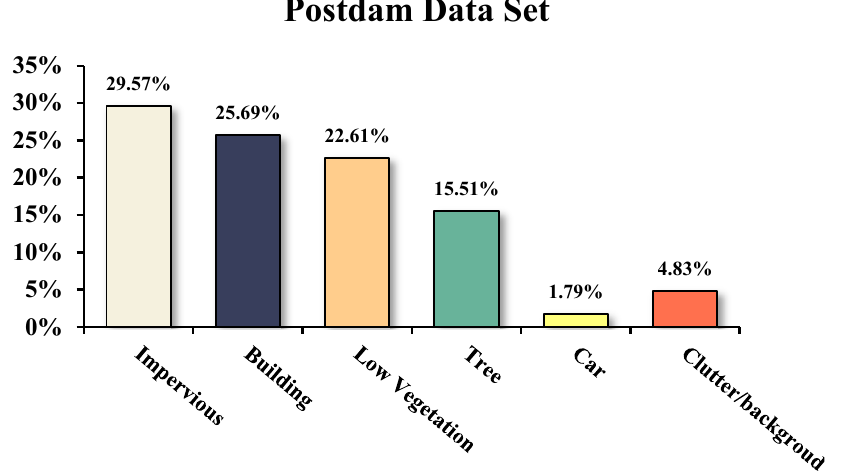
Figure 10. Proportion of each feature type in the Potsdam data set.